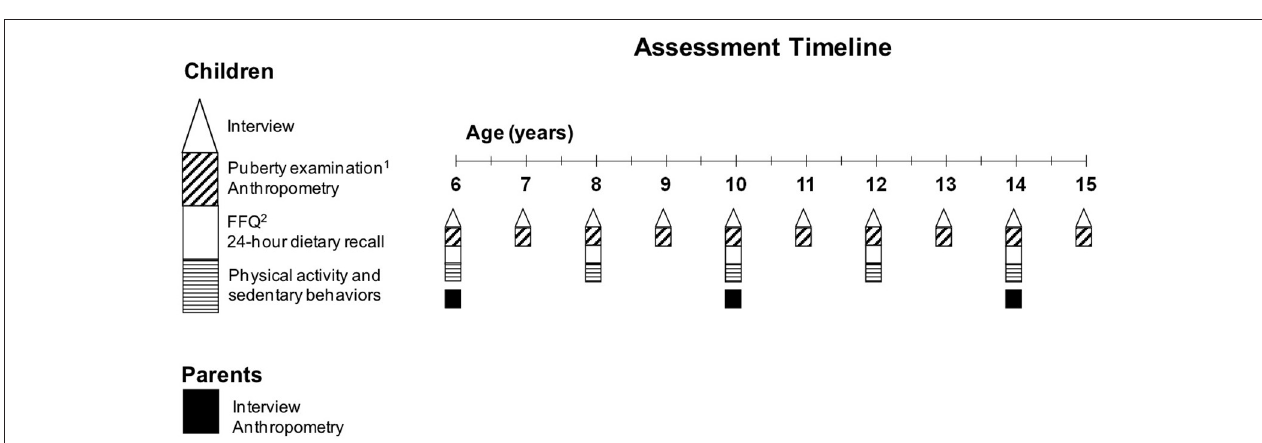
FIGURE 2 | Assessment timeline of the Chinese Adolescent Cohort study. 1 Puberty examination includes breast development and pubic hair development examinations in girls and testicular development and pubic hair development examinations in boys. In addition, children are asked whether menarche (girls), spermarche or voice break (boys) has already occurred and the respective month and year is recorded. 2 Food frequency